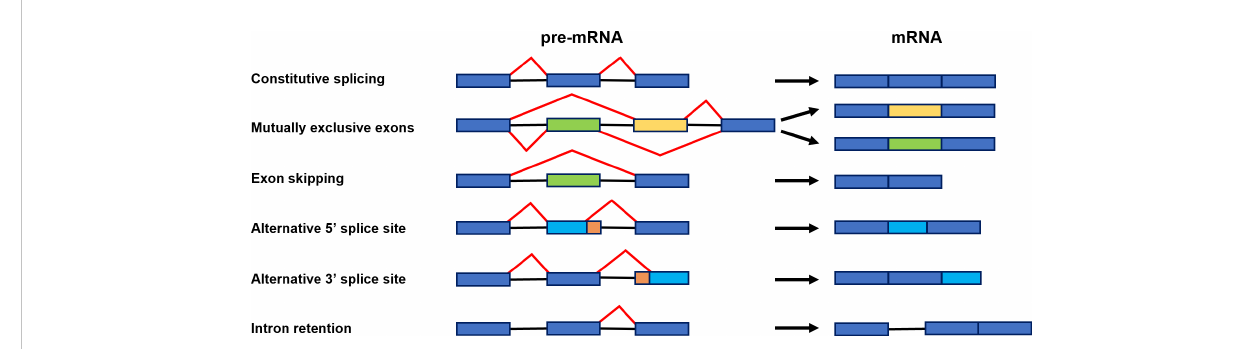
FIGURE 2 Scheme representing constitutive splicing and major alternative splicing events: constitutive splicing, mutually exclusive exons, exon skipping, alternative 5 ′ splice site, alternative 3 ′ splice site, and intron retention. Exons are shown as boxes and introns as black lines. Red lines illustrate distinct alternative splicing events (Gurnari et al.,